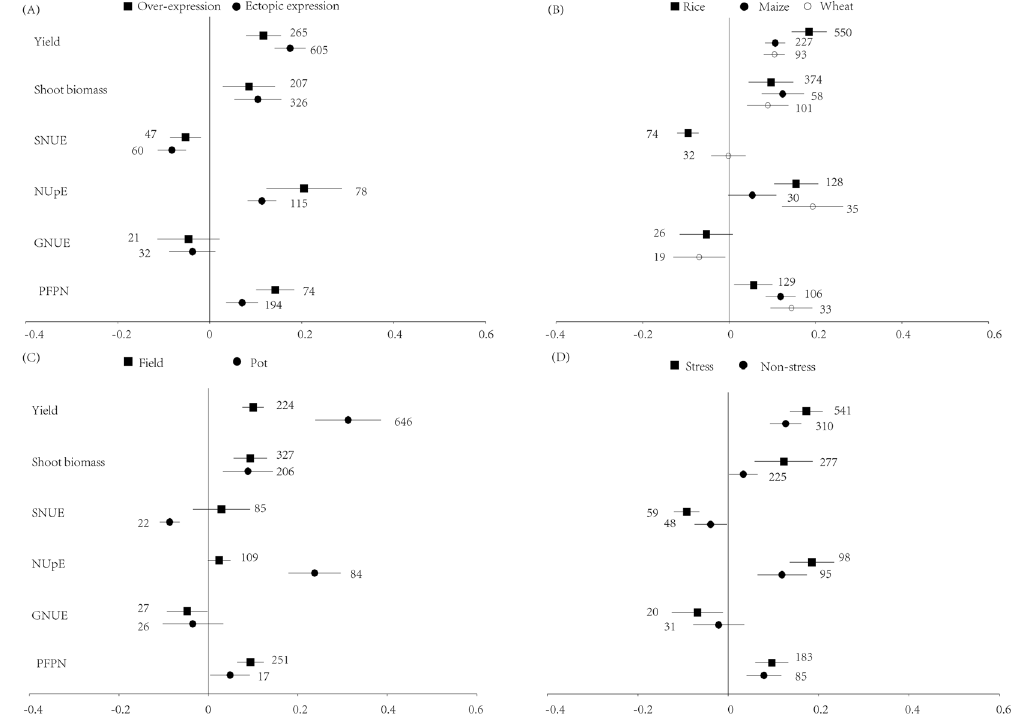
Figure 3. Effect sizes of yield, shoot biomass, shoot N utilization efficiency (SNUE), N uptake efficiency (NUpE), grain N utilization efficiency (GNUE) and partial factor productivity of N (PFPN) classified by transgenic types ( A ), crop species ( B ), experimental types ( C ) and environmental stress ( D ). The effects of genetic transformations were considered significant if the 95% CI of the effect size did not overlap with zero. The number of observations for each category are shown next to the error